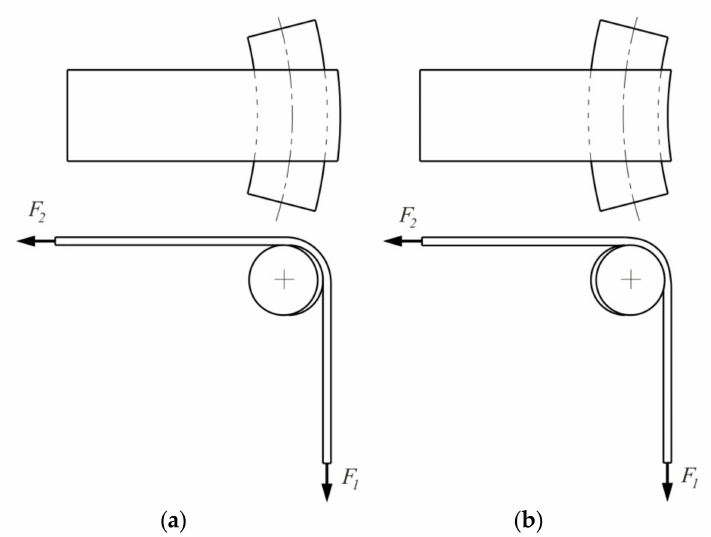
Figure 22. Proposed methods for the determination of the COF on a die edge with a ( a ) convex and ( b ) concave